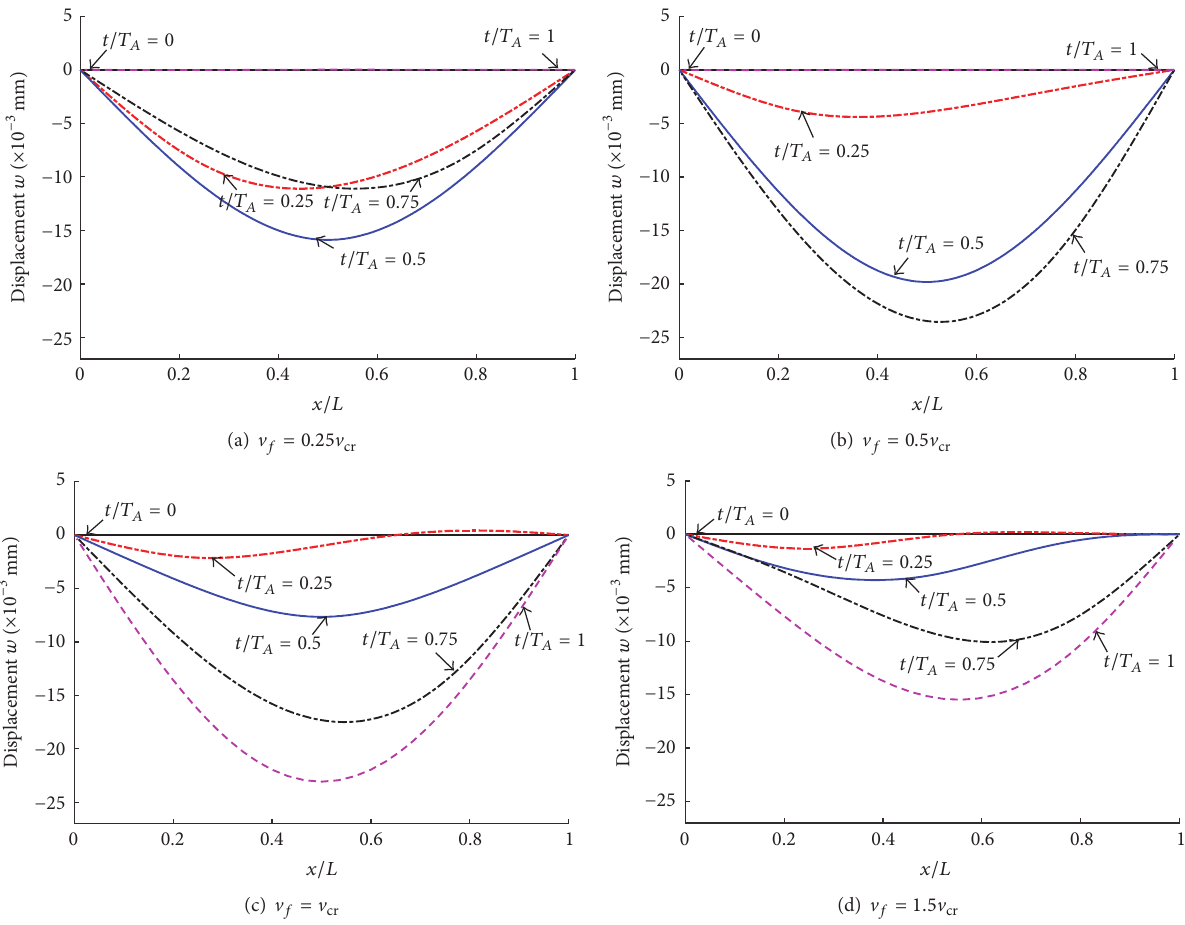
Figure 5: Deformed shapes of a simply supported Timoshenko beam at five different times ( 𝑡/𝑇 𝐴 = 0, 0.25, 0.5, 0.75, and 1) when the beam is subjected to a point transverse force moving at four different constant speeds: (a) V 𝑓 = 0.25 V cr ; (b) V 𝑓 = 0.5 V cr ; (c) V 𝑓 = V cr ; (d) V 𝑓 = 1.5 V cr , where V cr is the lowest critical speed.